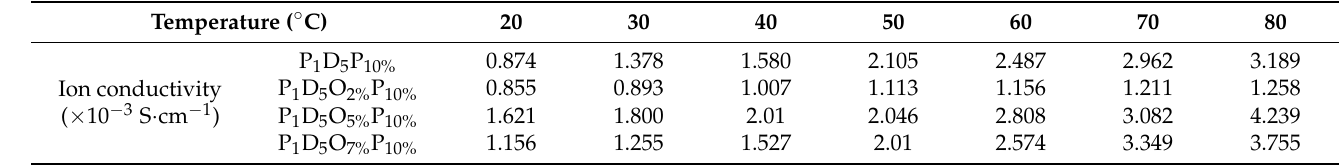
Table 2. Different temperature ion conductivity of polymer membranes prepared with different OVAPOSS doping amounts. Temperature ( ◦ C)